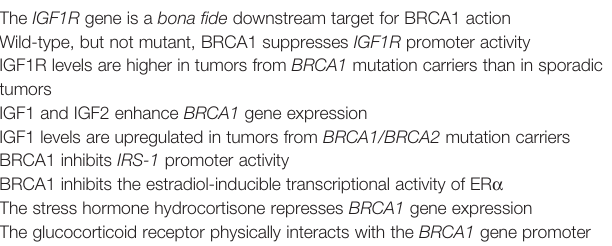
TABLE 1 | Interactions between BRCA1, steroid hormones and the IGF1 signaling pathway. The IGF1R gene is a bona fi de downstream target for BRCA1 action Wild-type, but not mutant, BRCA1 suppresses IGF1R promoter activity IGF1R levels are higher in tumors from BRCA1 mutation carriers than in sporadic tumors IGF1 and IGF2 enhance BRCA1 gene expression IGF1 levels are upregulated in tumors from BRCA1/BRCA2 mutation carriers BRCA1 inhibits IRS-1 promoter activity BRCA1 inhibits the estradiol-inducible transcriptional activity of ER a